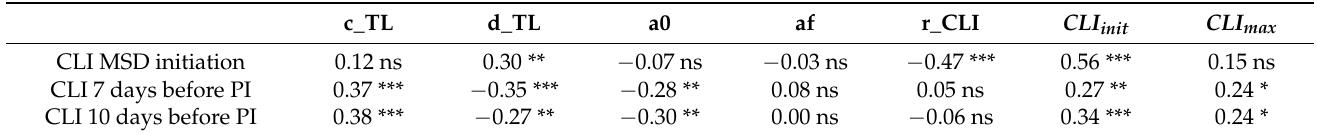
Table 3. Pearson’s correlation between the CLI values and tillering and canopy light interception dynamic simulation